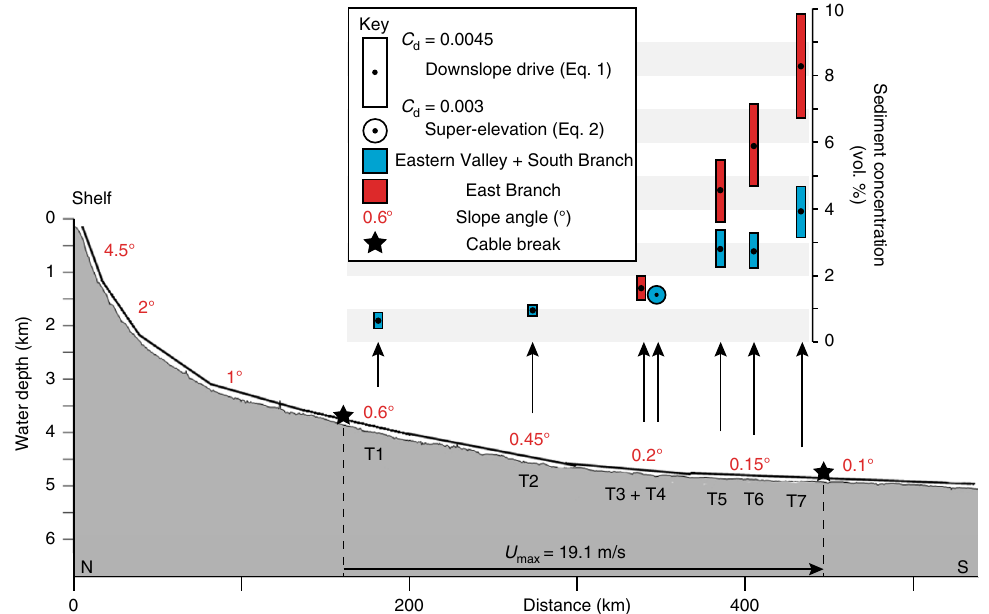
Fig. 4 Reconstruction of the bulk sediment concentration of the 1929 fl ow through the Eastern Valley channel system. Parameters from Eqs. (1) and (2) are constrained from the fi eld data, which allows sediment concentration ( C ) to be back-calculated: Velocity ( U ) from cable breaks (Fig. 1), fl ow thickness ( H f ) from channel trimlines (Fig. 2) and, slope gradient (sin θ ) from bathymetry (Fig. 1). Slope pro fi le trace is shown in Fig. 1. Frictional terms ( C d and E w ) in Eqs. (1) and (2) are not constrained by the fi eld data and must be estimated (see ′ Discussion ′ ). This introduces error into the estimates of sediment concentration